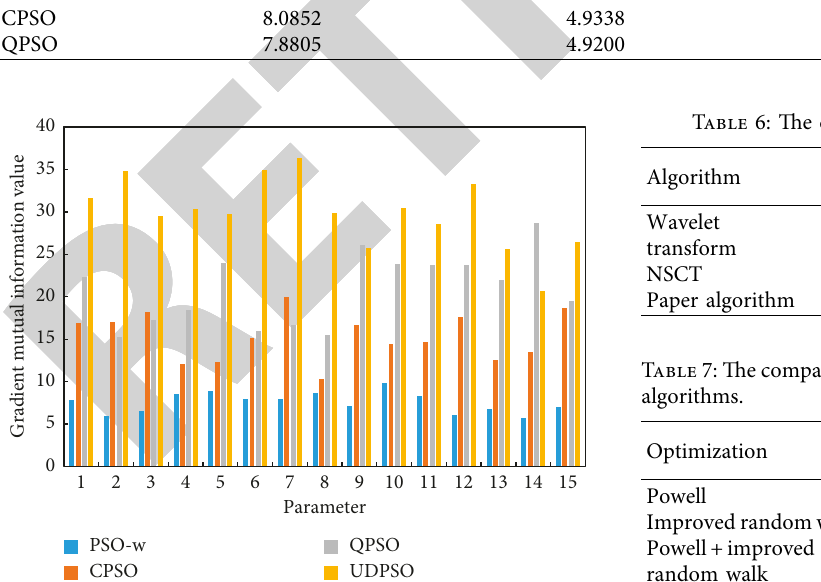
Figure 6: The registration convergence curves of different opti- mization algorithms are compared.